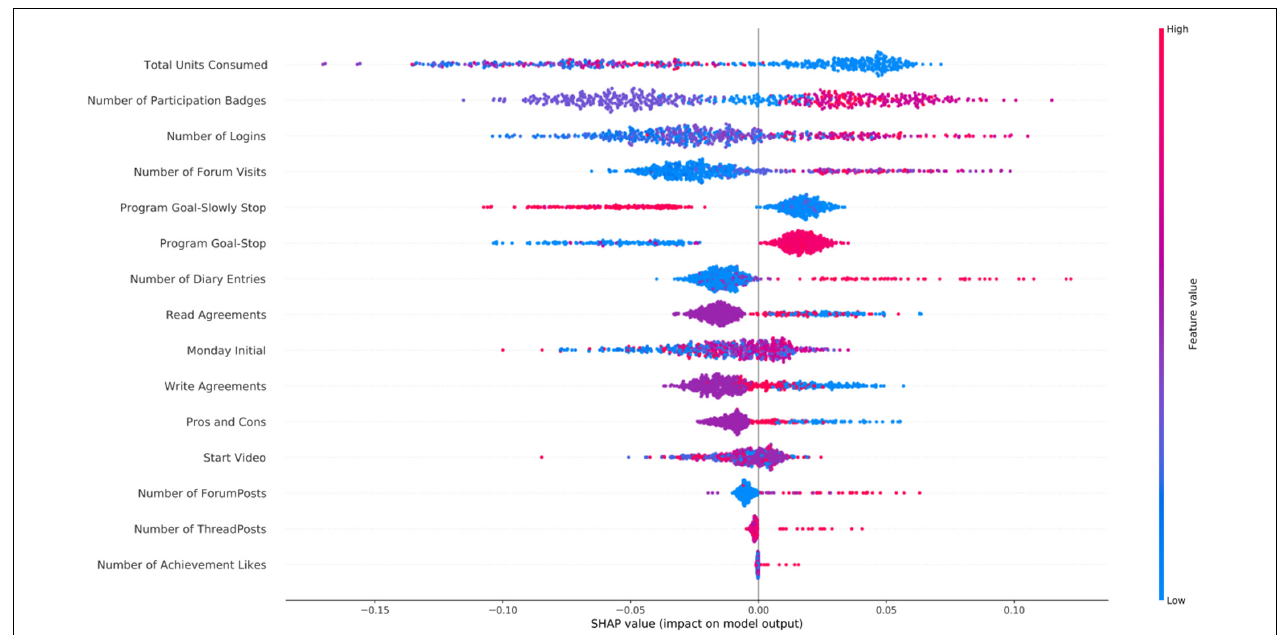
FIGURE 5 | SHAP feature importance for the tobacco intervention using the RFC model. Features are shown in order of importance, from most important (top) to less important (bottom). In the y -axis, we have the features based on the first 72 h of participation in order of importance from top (most important) to bottom (less important) and in the x -axis their respective SHAP value which indicates their association with success (SHAP values are above zero) or early dropout (SHAP values below zero) participant